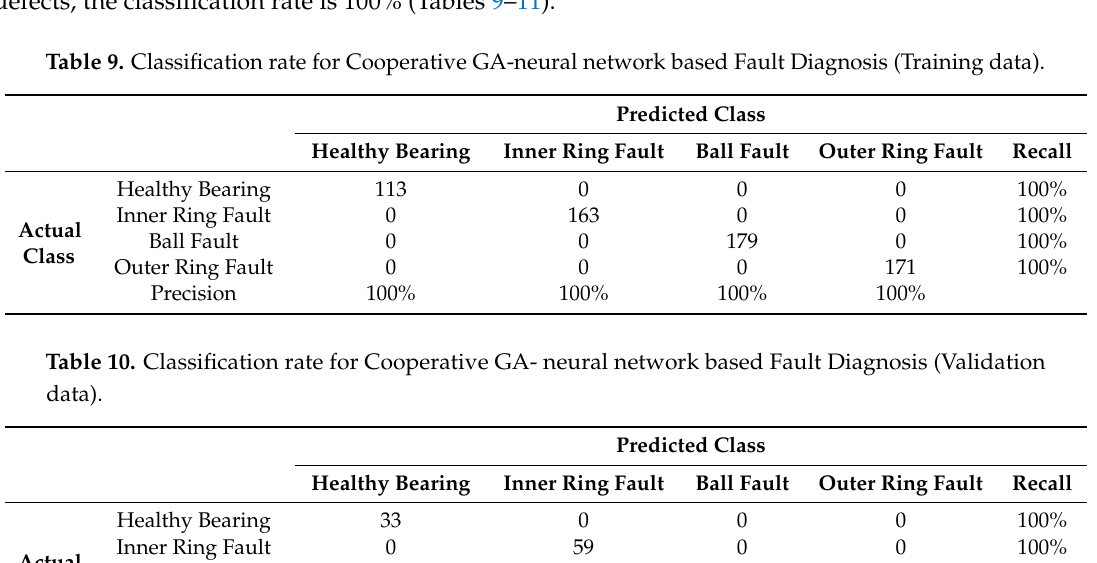
Figure 8. Cooperative Genetic Algorithm-neural network: Best Validation Performance.